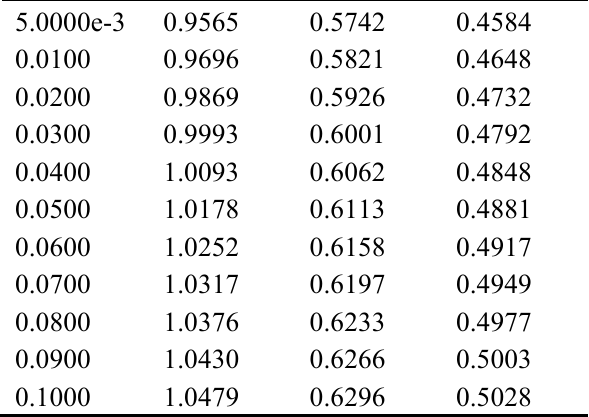
Table 7. Numbers used for plotting Figure 11 for e.m.f. of cell from solving the dielectric equation.